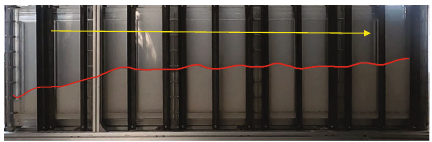
Figure 8: Embankment con fi guration of 40/70 mesh quartz sand with 8% sand ratio.